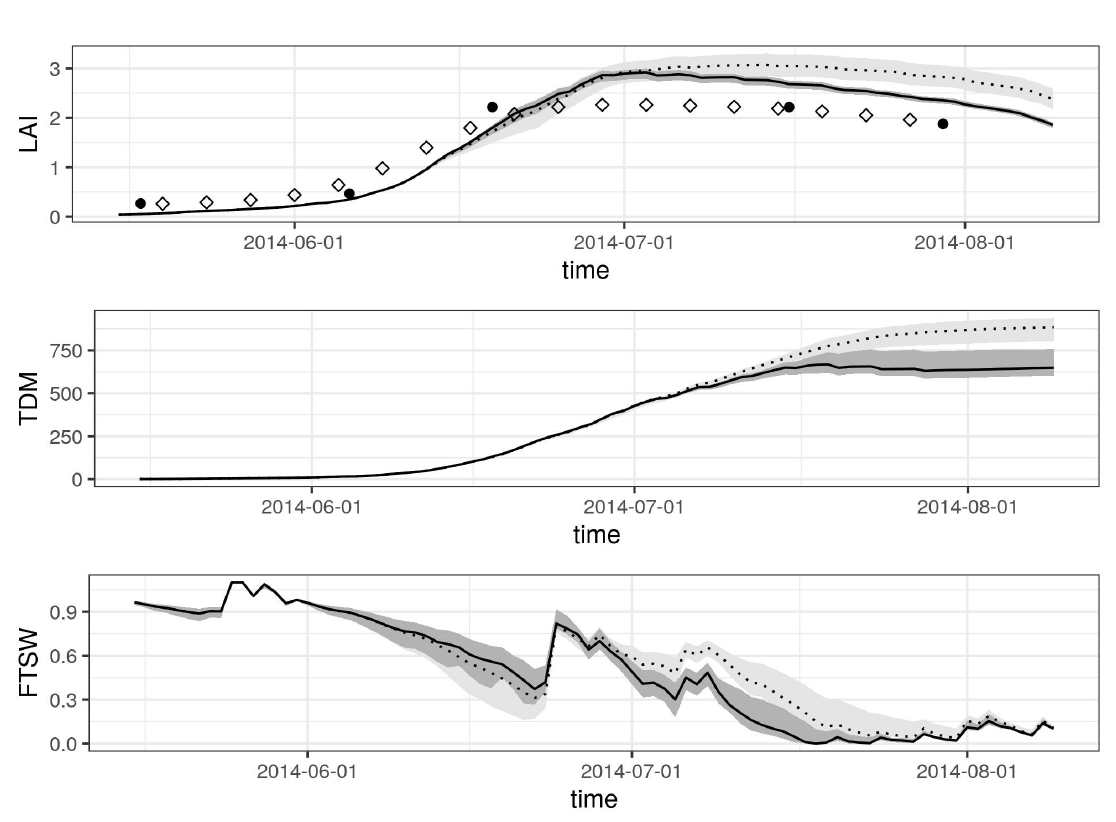
Figure 5. Illustration, on the same plot as in Figure 4, of the ensemble Kalman filter (EnKF) method to assimilate LAI observations and to correct trajectories of SUNFLO state variables LAI, total dry biomass (TDM) and the fraction of transpirable water (FTSW). Light gray (resp. dark gray) represents quartiles over the different model states of the simulated trajectory without assimilation (resp. with assimilation). Dots represents raw LAI observations and squares represent smoothed LAI